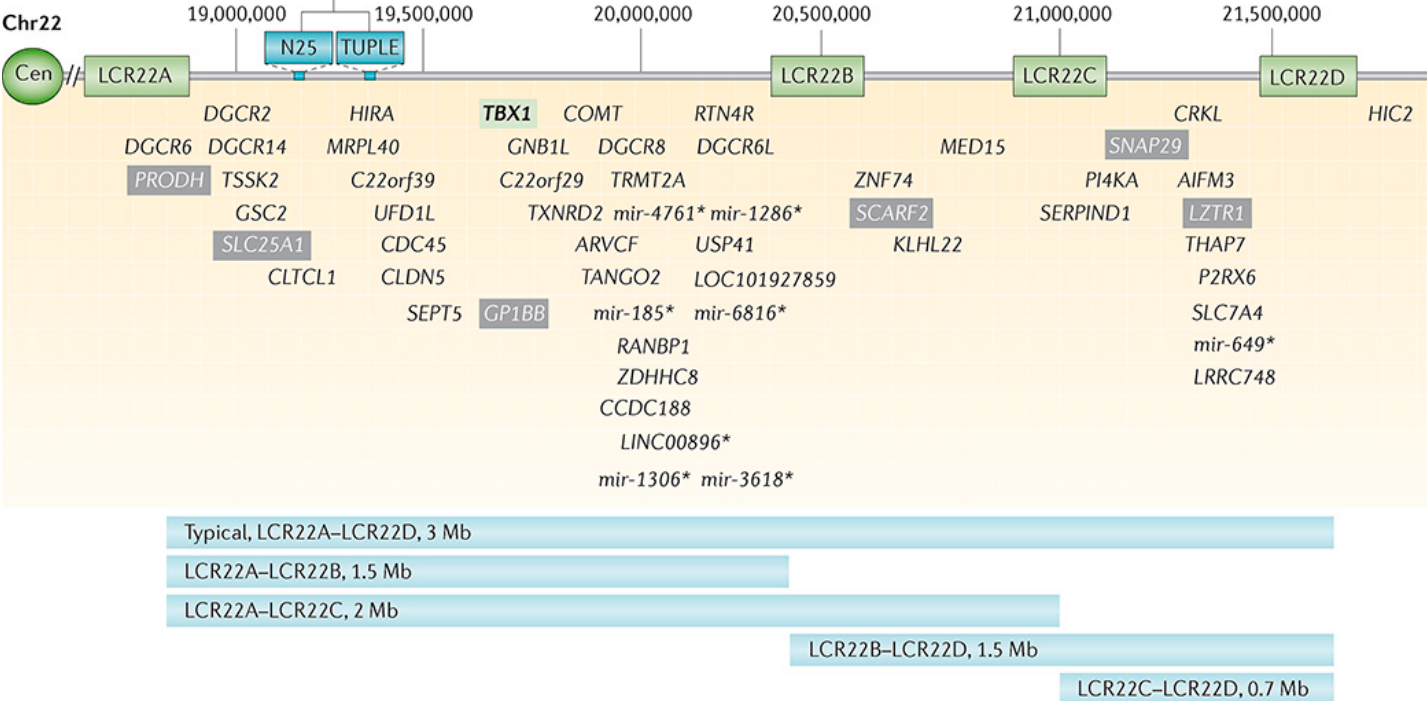
Figure 1. The depiction of the chromosome 22q11.2 deletion including the deleted genes and variations of the common deletions reported.